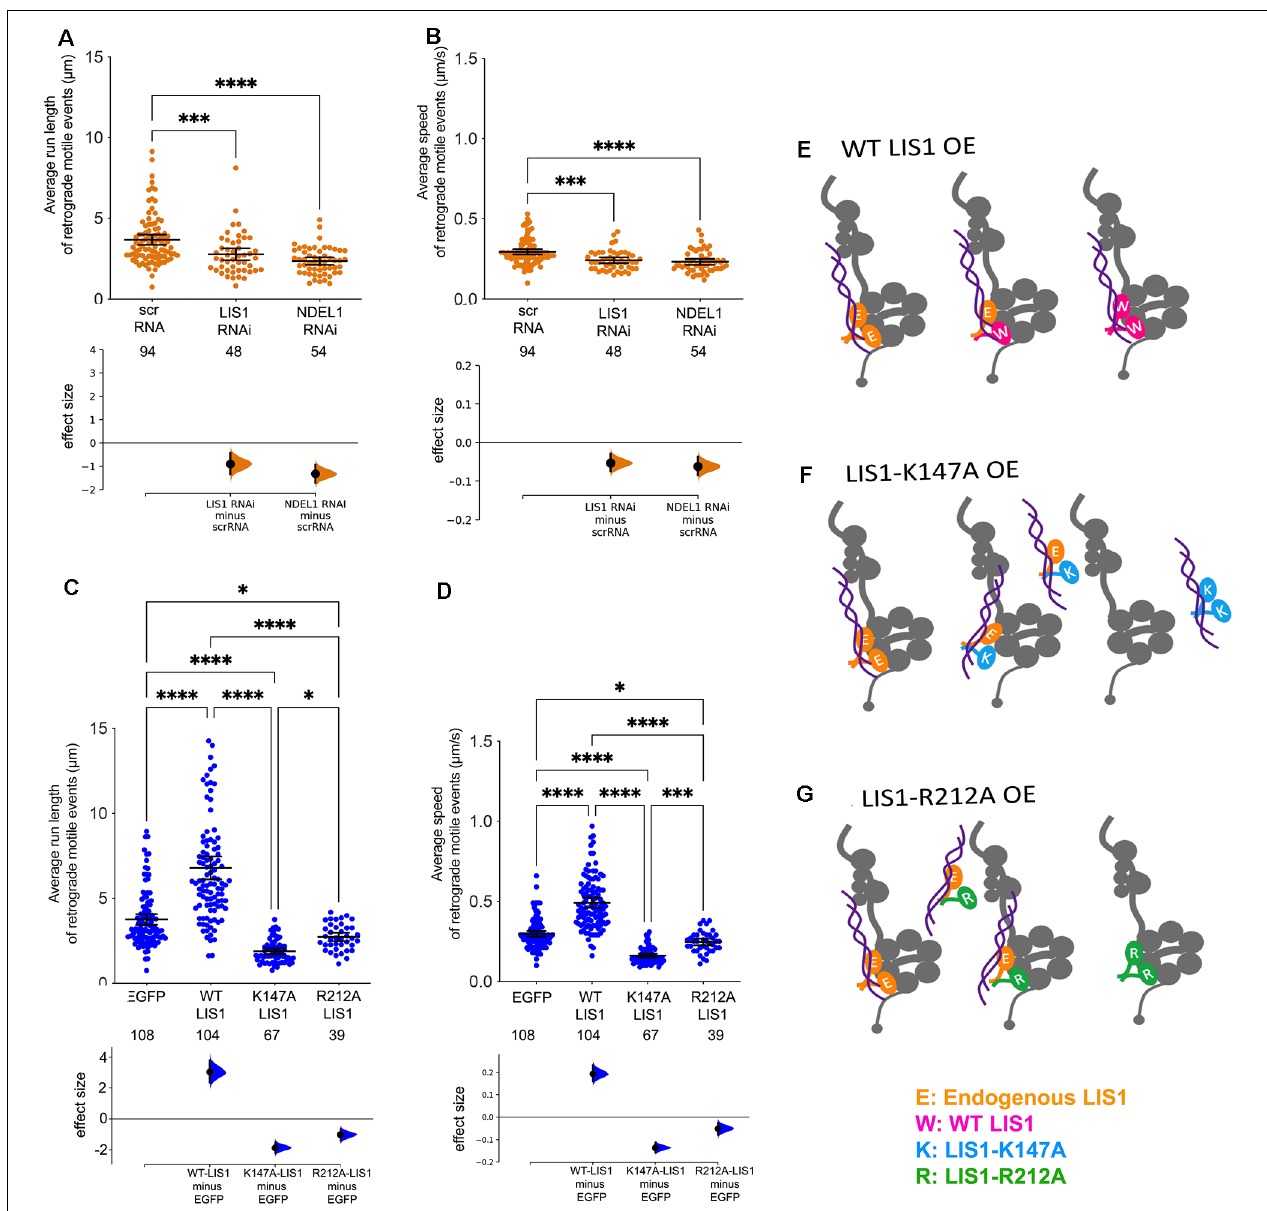
FIGURE 3 | Both LIS1 and NDEL1 impact the run lengths and average speeds of retrograde motile events (RMEs). (A–D) Average run lengths and average velocities of RMEs of axonal mitochondria were determined using manual tracking software. The data is from 12 axon segments imaged in DRG cultures from three different adult rats (four axons from each rat). Each axon segment typically had 10–30 mitochondria, some of which moved during the recording interval. A single mitochondrion can undergo more than one RME. The numbers of individual RMEs measured in all 12 axon segments per condition are shown below the X-axis labels. Run lengths (A) and average speeds (B) are significantly reduced by RNAi-mediated KD of LIS1, NDEL1, or DHC. The raw data is plotted on the upper axes. Each point corresponds to a single axon (of 12 axons measured from three independent cultures from three different rats). Error bars show the mean ± 95% confidence interval.The effect size is visualized on the lower axes, in which mean differences from a shared control are plotted as bootstrap sampling distributions. Mean difference is depicted as a dot and 95% confidence interval is indicated by the ends of the vertical error bars. OE of WT LIS1 significantly increases both the run lengths (C) and average speeds (D) of RMEs, while both LIS1-K147A or LIS1-R212A significantly reduce run lengths and average speeds. For all data, significance was determined by Kruskal-Wallis nonparametric ANOVA with multiple comparisons using the two-stage linear step-up procedure of Benjamini, Kreiger and Yekutieli to control for false discovery rate. ∗∗∗∗ p < 0.0001; ∗∗∗ p < 0.001; ∗ p < 0.05. (E–G) Schematics depicting potential impacts of OE of different LIS1 constructs. (E) WT-LIS1 (W, pink) could form homodimers and heterodimers with endogenous LIS1 (E, orange) all of which are likely able to stimulate dynein. (F) LIS-K147A (K, blue) homodimers should not be able to bind to and stimulate dynein but may sequester NDEL1 away from endogenous LIS1/dynein complexes. Heterodimers with endogenous LIS1 may partially bind to dynein and NDEL1, but given our results, this likely to exert dominant negative effects on dynein activation. (G) LIS1-R212A (R, green) homodimers may bind to dynein but should not be complexed with NDEL1. Heterodimers with endogenous LIS1 may only partially bind to dynein and NDEL1, again likely exerting dominant negative effects.